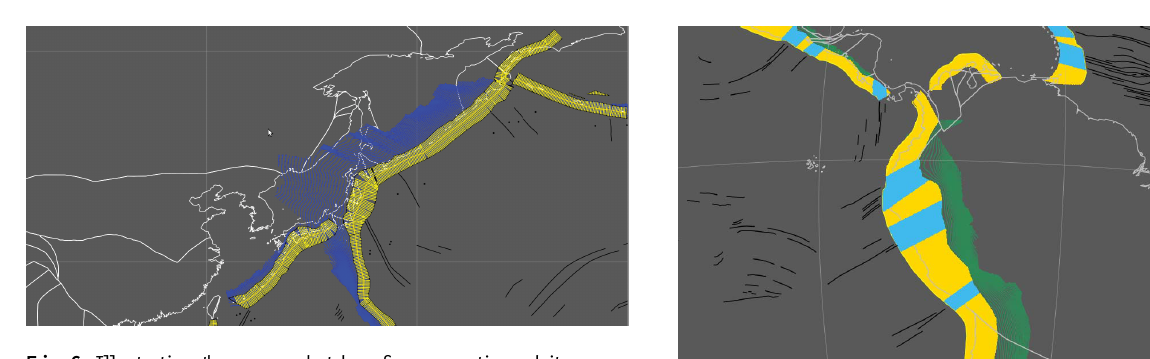
Fig. 6. Illustrating the approach taken for computing arbitrary as- sociations for the Northwest Pacific region. Yellow lines along the coupling zone define a collection of arbitrary spatial regions (at ap- proximately 20km spacing) that are used to construct experiments involving repeated unbiased sampling at random. The Slab 1.0 3- dimensional subduction zone model is shown in blue, coastlines in white, and fracture zones in black.